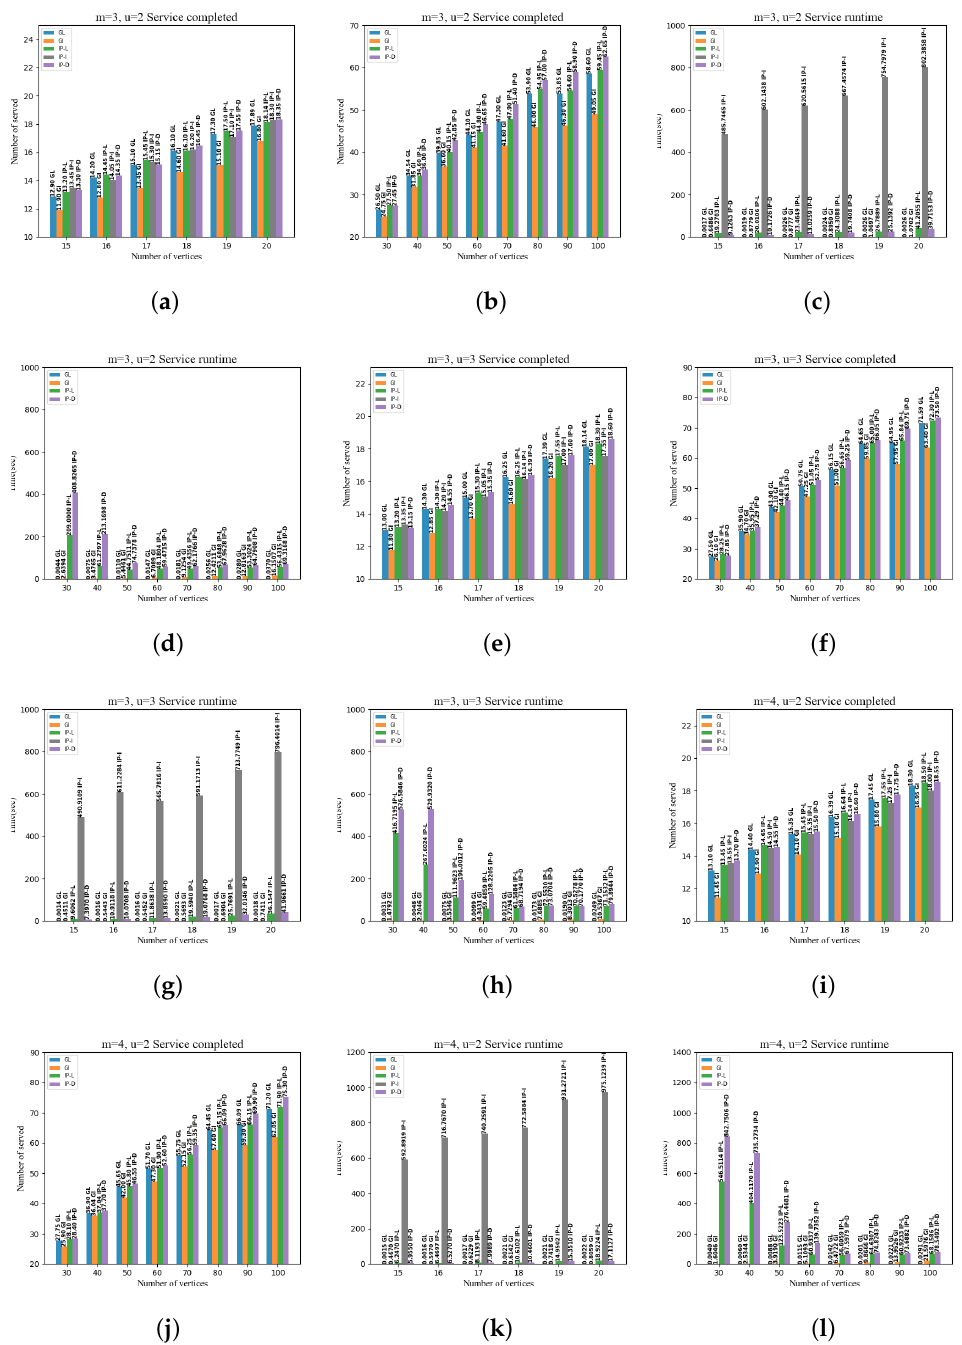
Figure 6. The performance of our approach and baseline algorithms in the m -principal- u -assistant scenario. Test of the Number of Served Vertices in the 3-principal-2-assistant scenario: ( a , b ); Test of the Running Time in the 3-principal-2-assistant scenario: ( c , d ); Test of the Number of Served Vertices in the 3-principal-3-assistant scenario: ( e , f ); Test of the Running Time in the 3-principal-3-assistant scenario: ( g , h ); Test of the Number of Served Vertices in the 4-principal-2-assistant scenario: ( i , j ); Test of the Running Time in the 4-principal-2-assistant scenario: ( k , l ). In general, the number of vertices served by the IP-D is largest among all the algo- rithms, although the running time of the IP-D is also largest among them; however, this is reasonable in